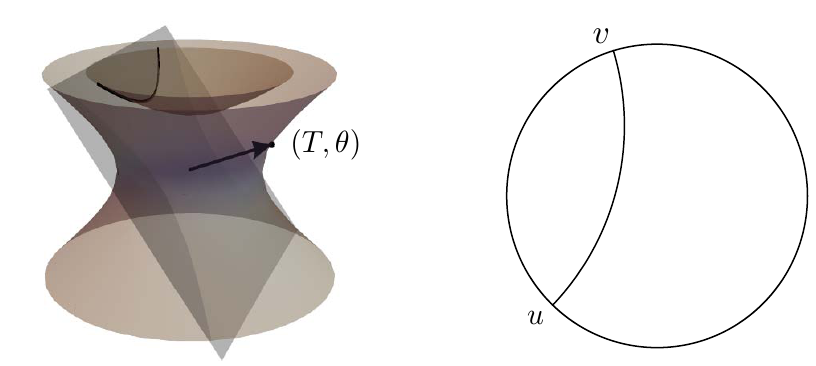
Figure 4 . Left: geodesics in the hyperbolic plane correspond to points, ( T, θ ), in the single sheeted hyperboloid. Right: the same geodesic projected onto the Poincar´e